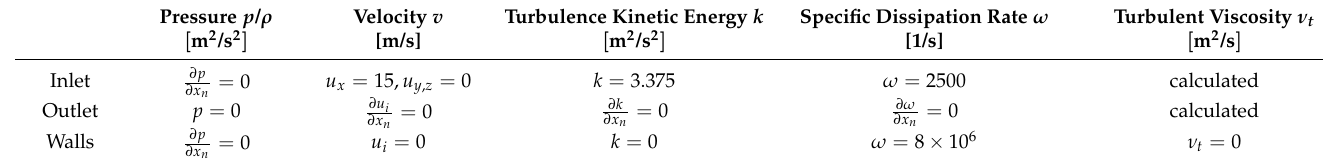
Table 4. Fluid simulation boundary conditions.